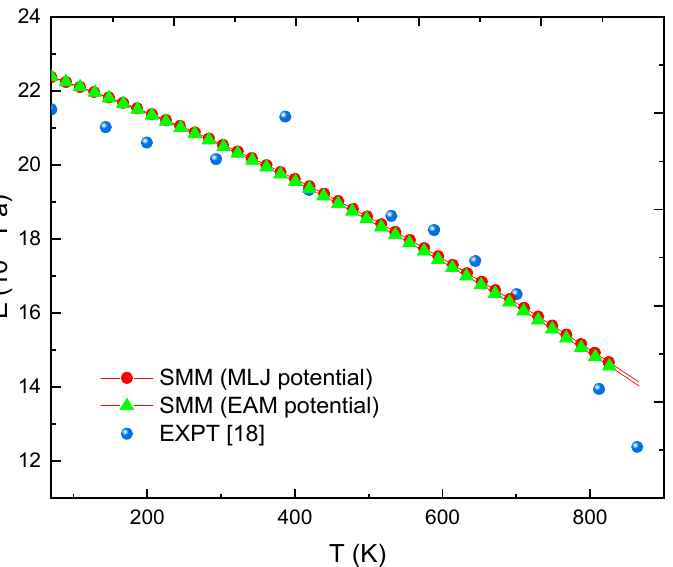
Figure 4. E(T) at P = 0 calculated by SMM with MLJ potential, SMM with EAM potential [47] and from EXPT [18] with FeC 0.4% alloy.